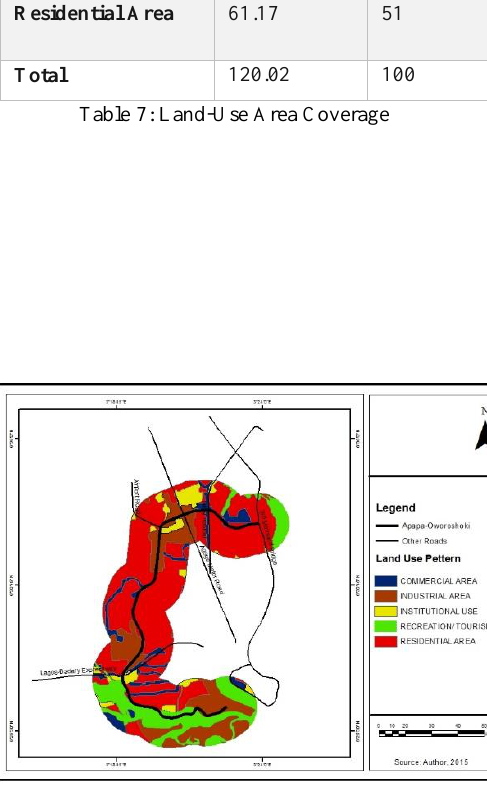
Figure 8: Land-Use Pattern